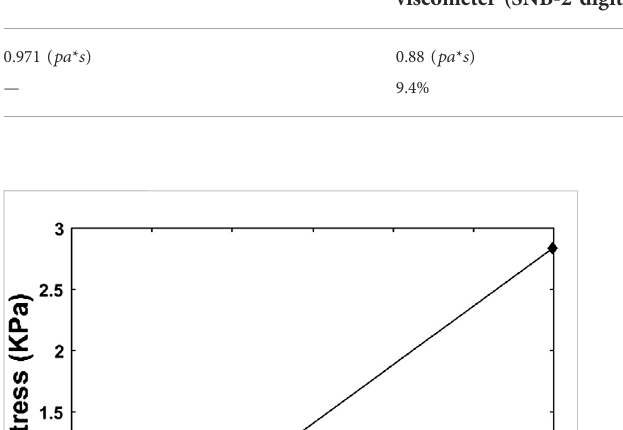
TABLE 2 Comparison of the viscosities obtained in different methods. Given product parameters